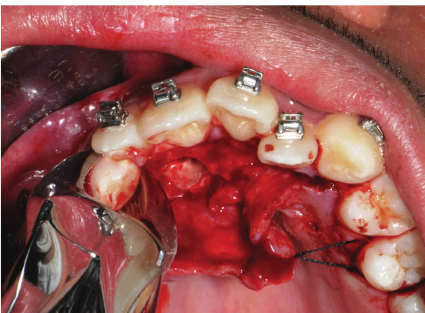
Figure 7: Surgical removal of compound